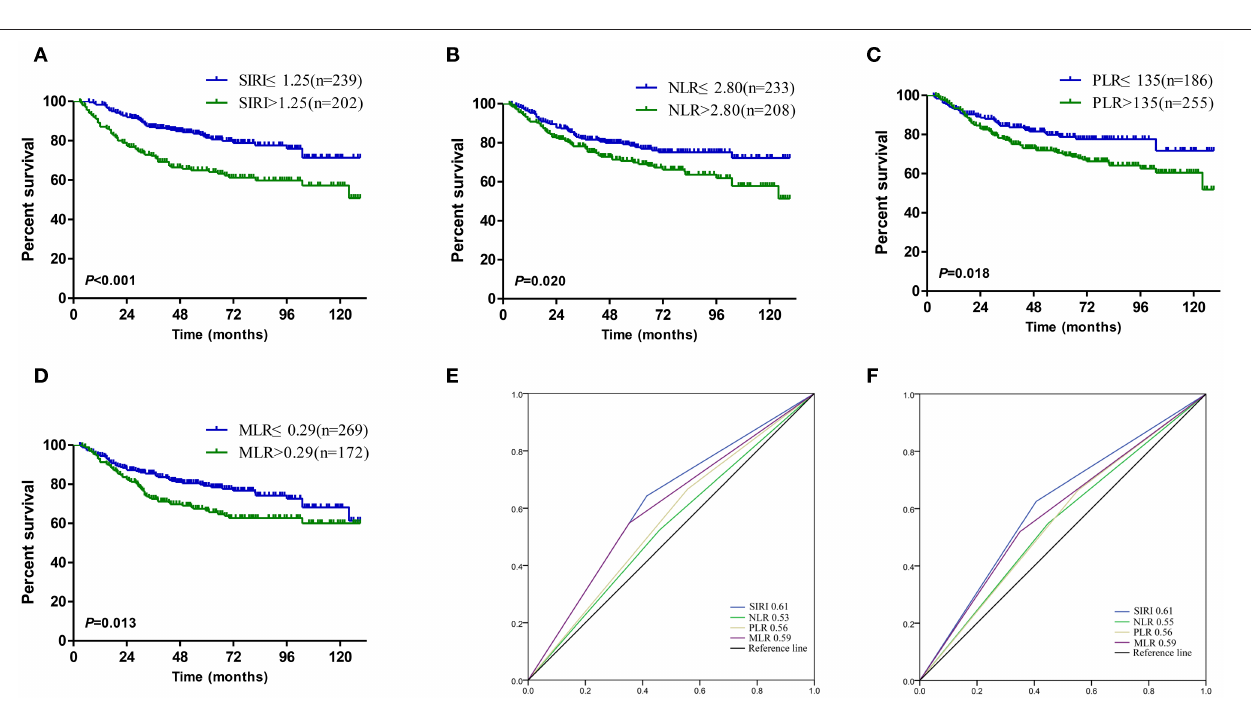
FIGURE 1 | Kaplan–Meier curves for patients stratified based on (A) SIRI, (B) NLR, (C) PLR and (D) MLR in operable cervical cancer patients. Predictive ability of the SIRI in operable cervical cancer patients was compared with NLR, PLR, and MLR by ROC curves in 3-years (E) and 5-years (F) .